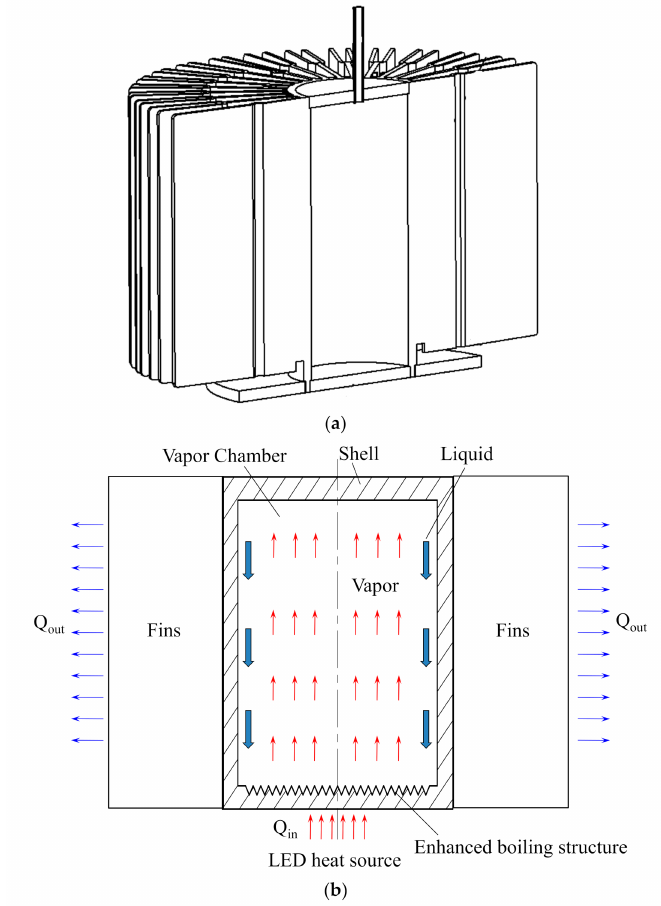
Figure 1. ( a ) Geometry of the developed radial heat sink for high-power light-emitting diode (LED) heat dissipation and ( b ) its operating